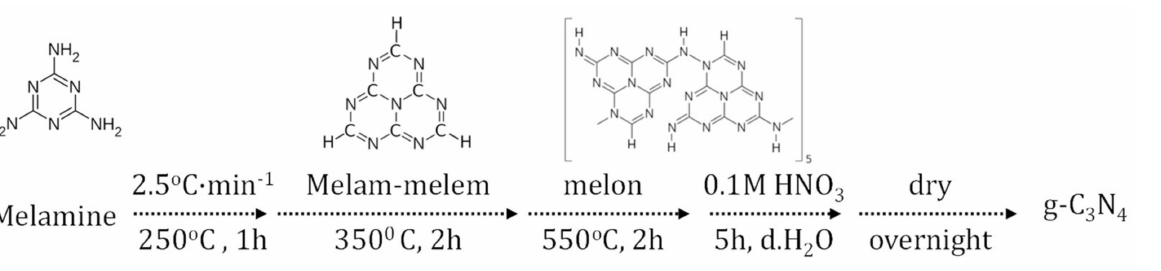
Figure 4. Schematic diagram of a typical pyrolysis procedure for g-C 3 N 4